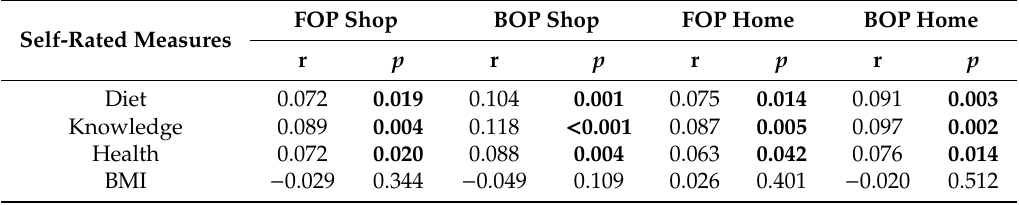
Table 9. Pearson correlation coe ffi cients of reading food labels with the self-rated healthiness of one’s diet, self-rated knowledge about healthy nutrition, self-rated health, and BMI. Self-Rated Measures